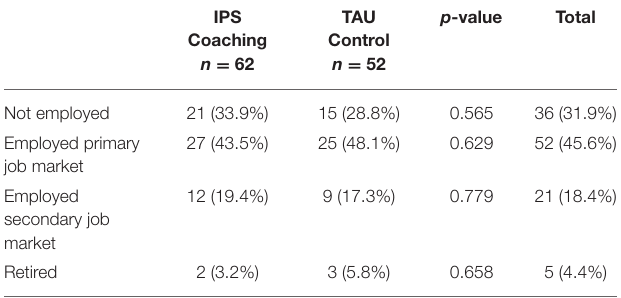
TABLE 2 | Employment status at the follow-up interviews. TABLE 3 | Model estimate of the number of positions acquired in the primary work market over the various time